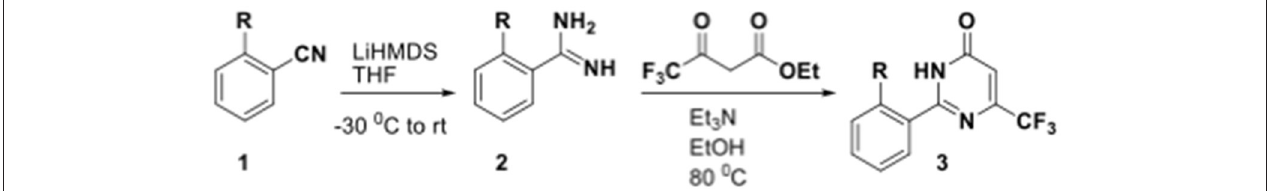
TABLE 1 | Activity of compounds with substitutions at the 2-position of the pyrimidinone.